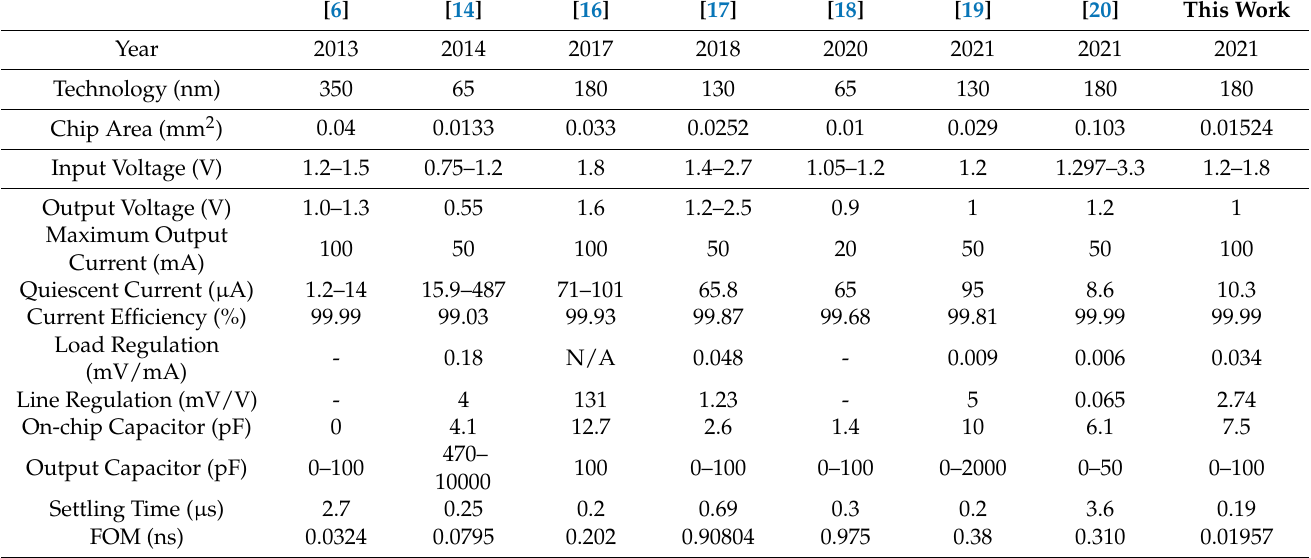
Table 2. Performance summary and comparison with state-of-the-art